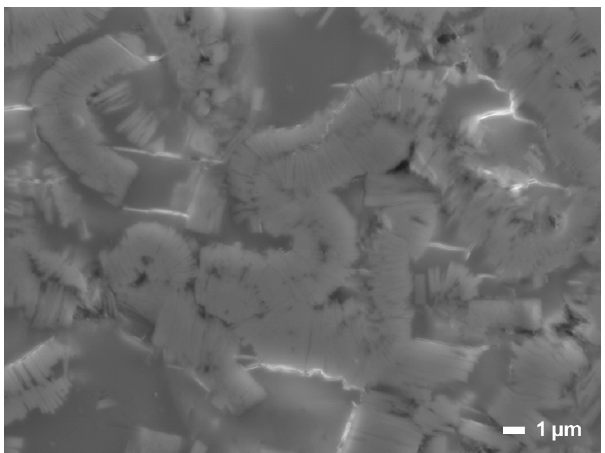
Figure 6. SEM micrograph showing the heterogeneous microtexture of Fe ‐ rich celadonite (17.69 wt. % Fe according to EDX analysis) with agglutinated platelets forming worm ‐ like structures.